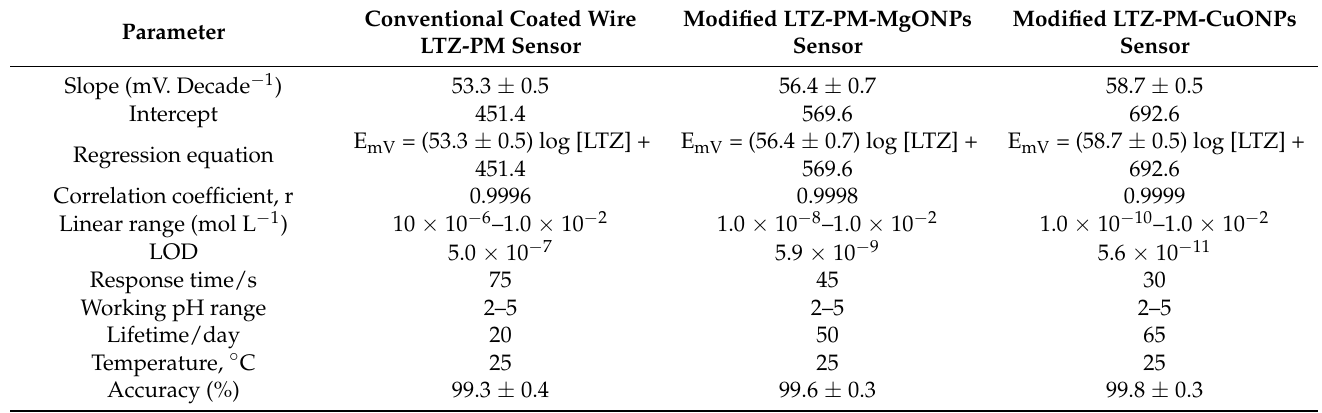
Table 1. Performance characteristics of fabricated conventional coated wire LTZ-PM and modified LTZ-PM-MgONPs and LTZ-PM-CuONPs sensors.